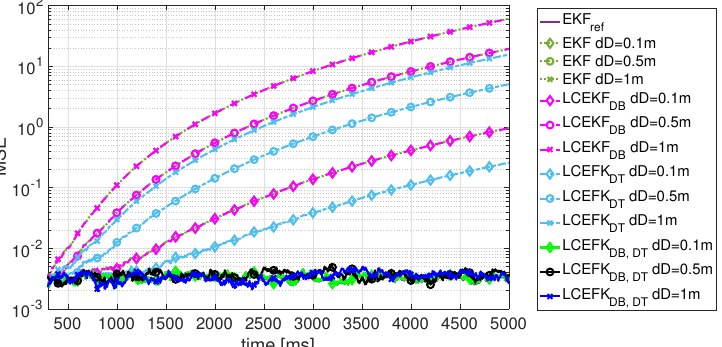
Figure 3. Results for the different sceanrios: ( Top ) Additive noise S1, ( Middle ) non-additive noise S2, and ( Bottom ) both additive and non-additive noise S3. MSE results for the optimal EKF ref , mismatched EKF, and three LCEKF implementations: LCEKF DB (mitigation of dD B ), LCEKF DT (mitigation of dD T ), and LCEKF DB , DT (mitigation of both dD B and dD T